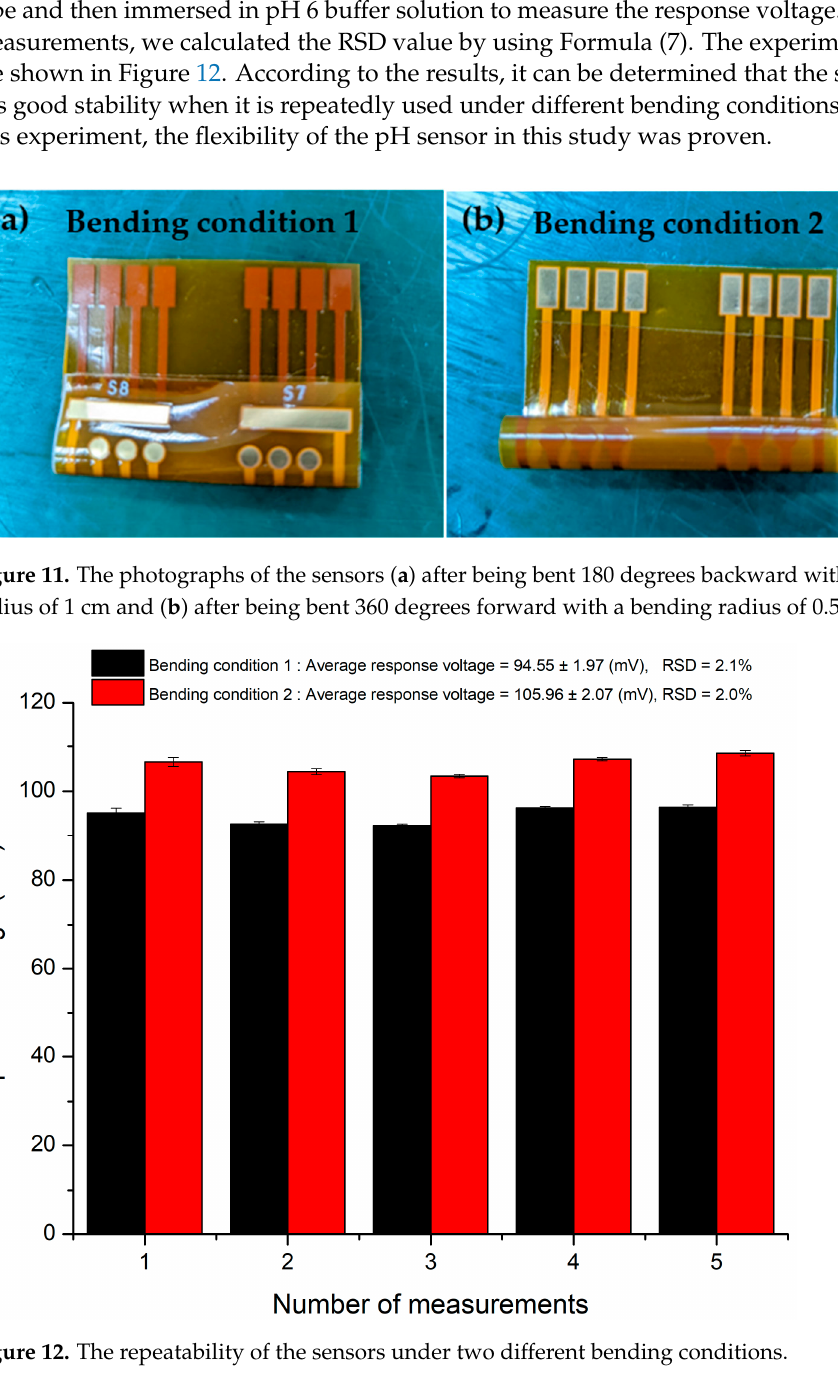
Figure 10. The average sensitivity and linearity of the pH sensor after 0, 50, 100, 150, and 200 bending cycles.